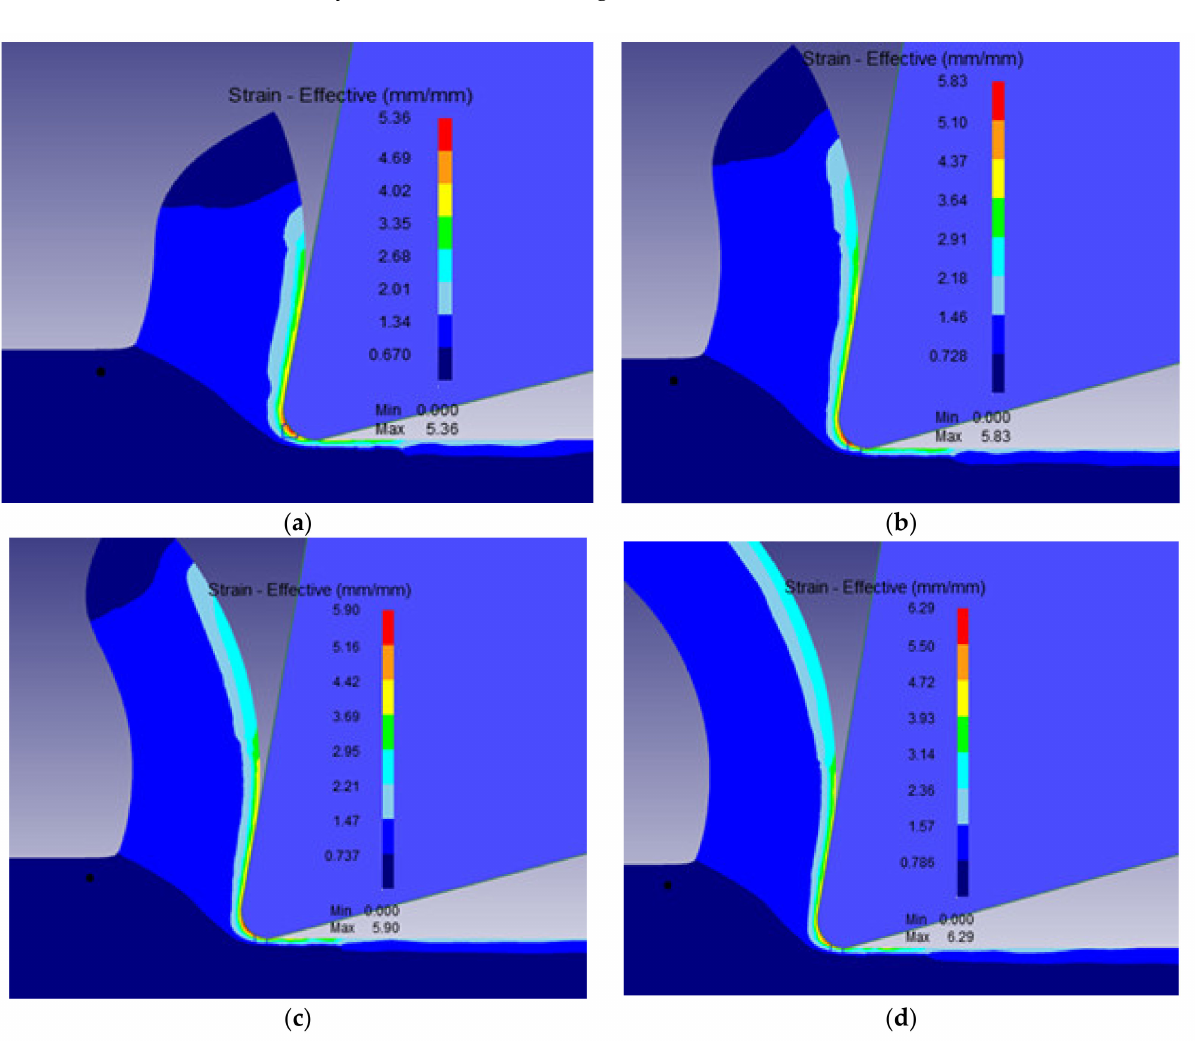
Figure 7. Distribution of effective strain in the workpiece and cutting tool at V = 400 m/min f = 0.1 mm/rev, γ = 5 ◦ for the nose radii r c : ( a ) 0.3 mm, ( b ) 0. 5 mm ( c ) 0.7 mm and ( d ) 0.9